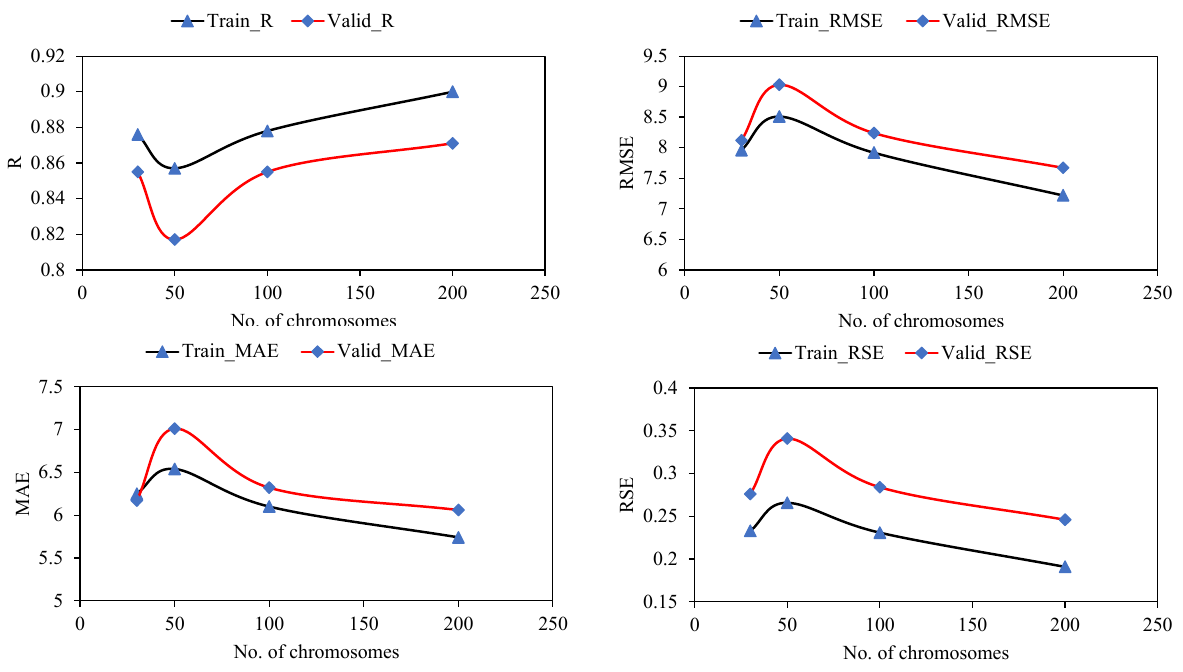
Figure 4. Effect of number of chromosomes on statistical evaluation of the developed GEP models.